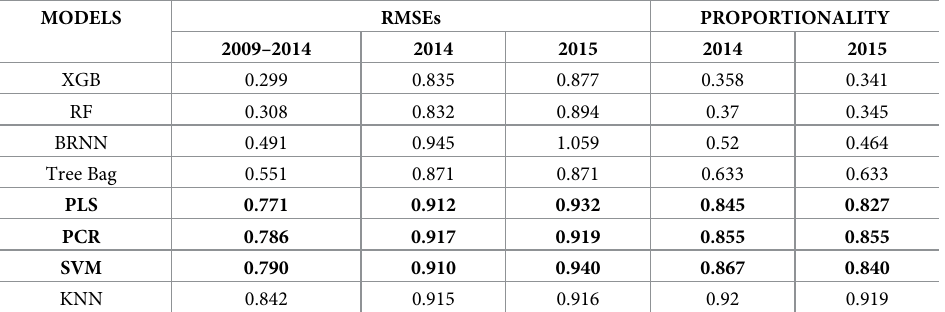
Table 1. Calibration of tested models ordered according to the performance indicator (RMSEs and proportional- ity between the RMSEs). MODELS